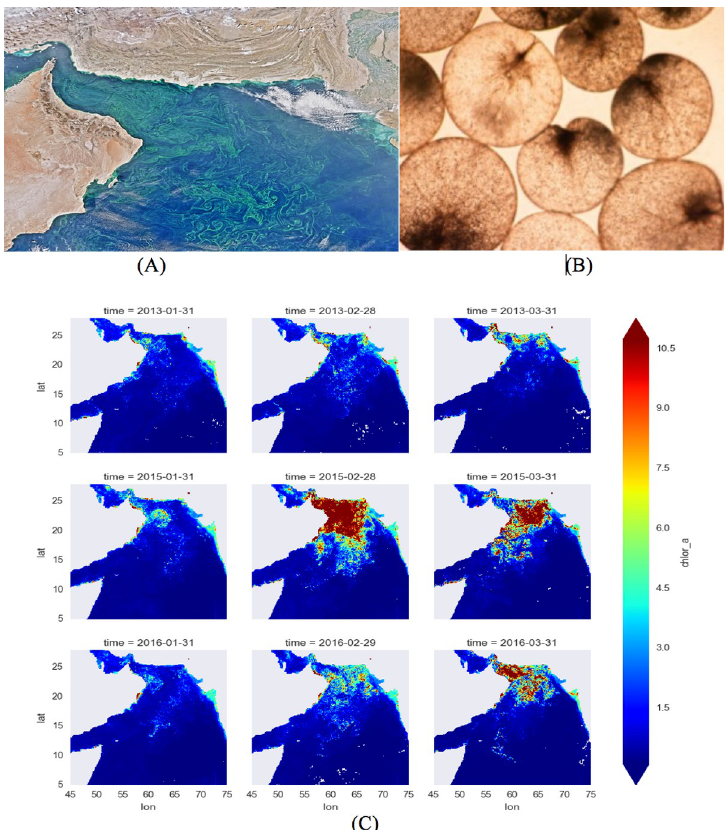
Fig 1. (A) Satellites images displaying Noctiluca blooms as large swirls on the surface of the Arabian Sea [40]. (B) Noctiluca scintillans with a flick of its tail-like flagellum drawing energy from the millions of green algae, or “endosymbionts”, captured inside its transparent cell walls. (C) Satellite image for the monthly data of the chlorophyll a concentration in the Arabian Sea during year 2013, 2015, and